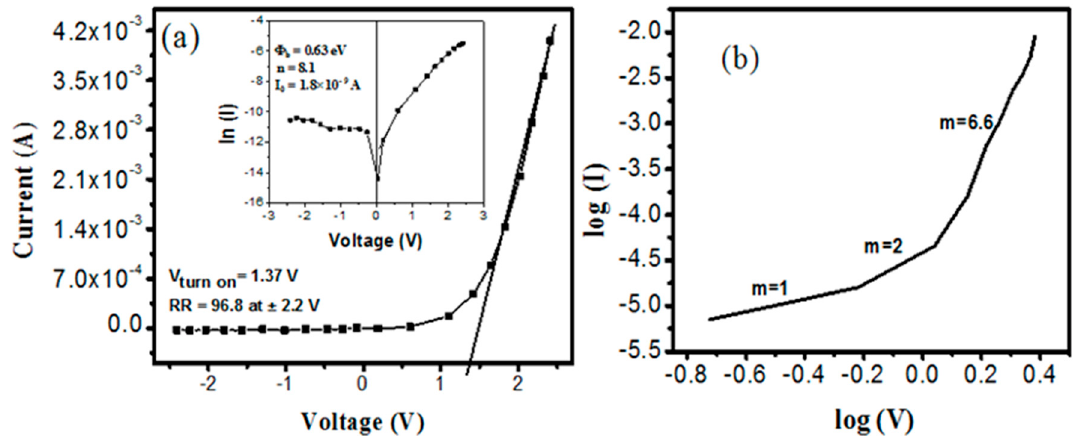
Figure 4. Current–voltage (I-V) curves of ITO/PEDOT:PSS/PFB–PCBM/Ag BHJ solar cell in dark; inset: ( a ) The semi-log I-V ( b ) The log I-log V.